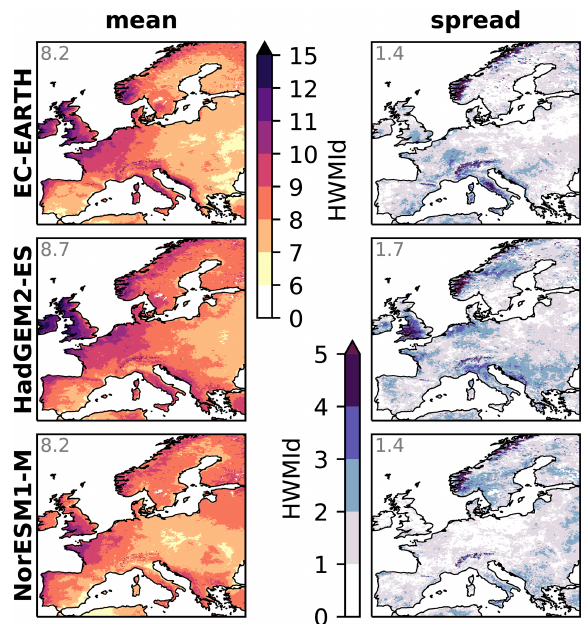
Figure 4. Ensemble mean and spread (maximum − minimum) of simulated HWMId under the recent past climate (1981–2020) for each row in the RCM simulation matrix indicating the uncertainty associated with different RCMs. The numeral in each map shows the area-weighted